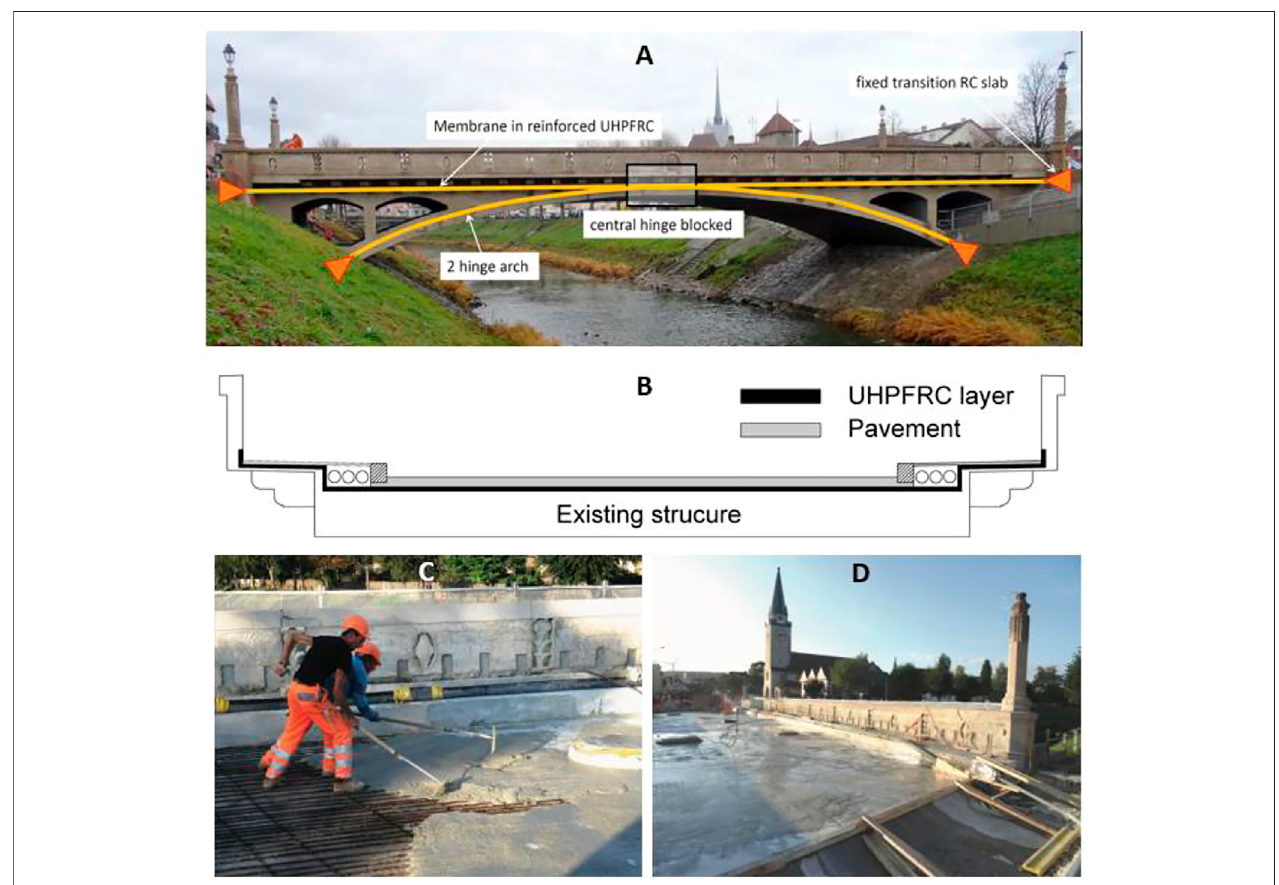
FIGURE 8 | Guillermaux Bridge. (A) , (B) static system and intervention; (C) , (D) Photographs of the pouring UHPFRC (Photograph A. Herzog).